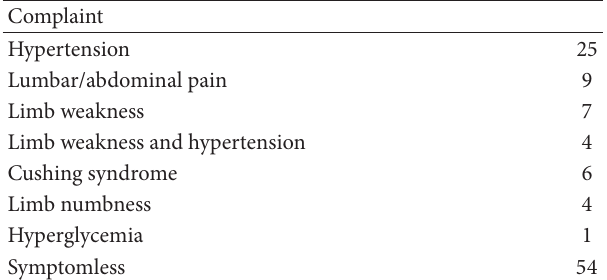
Table 1: The complaints of all patients.